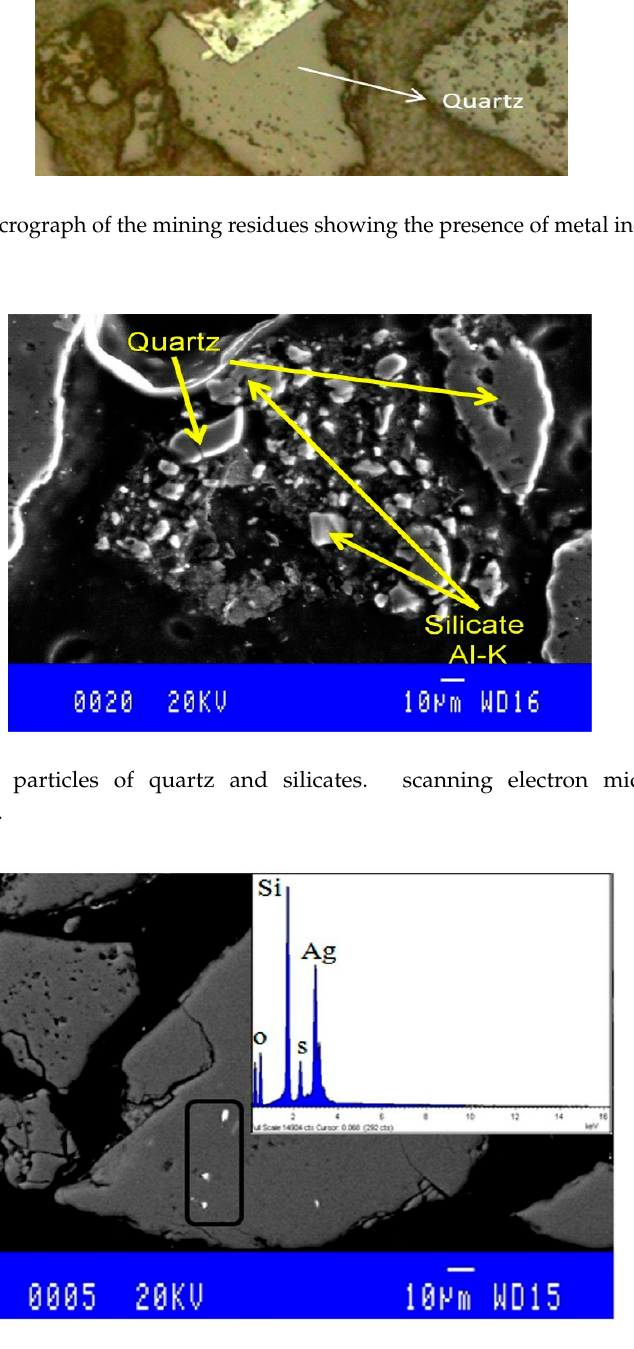
Figure 4. Backscattered electron image and energy dispersive X-ray spectrometry (EDS) spectrum showing the presence of silver sulfide encrusted in a quartz matrix.